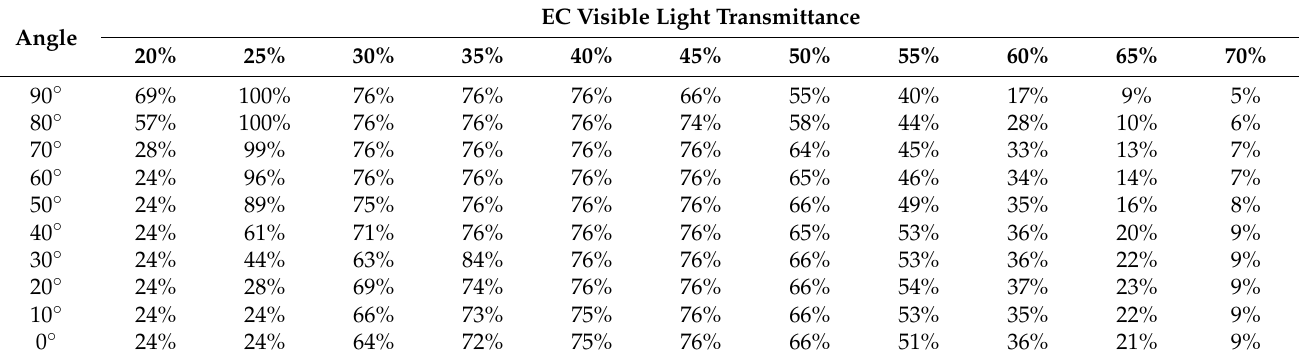
Table 7. Target illuminance achievement rates when the number of divisions of louvers is 13.